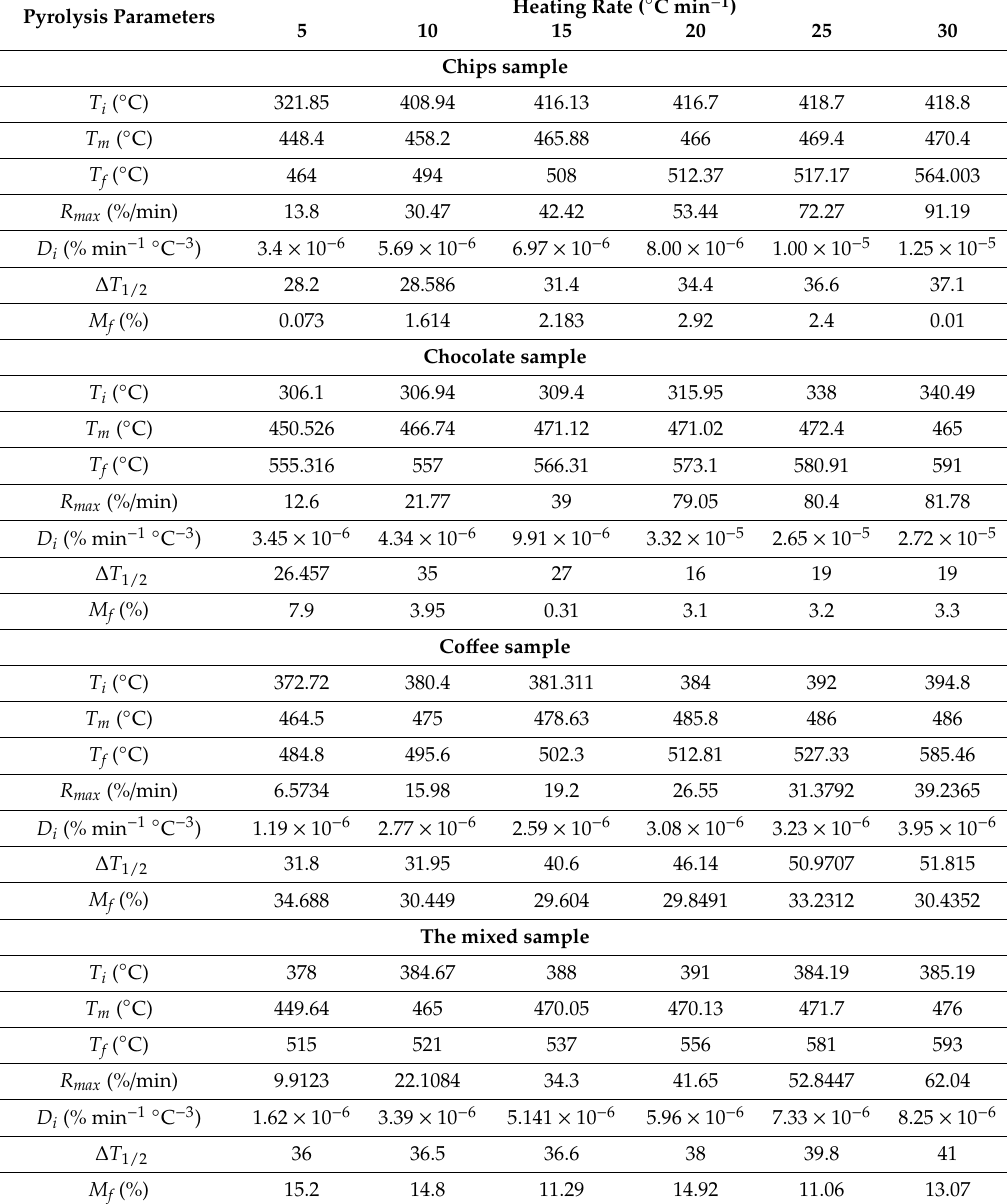
Table 3. The pyrolysis characteristic parameters for metalized food packaging plastics waste (MFPWs) at di ff erent heating